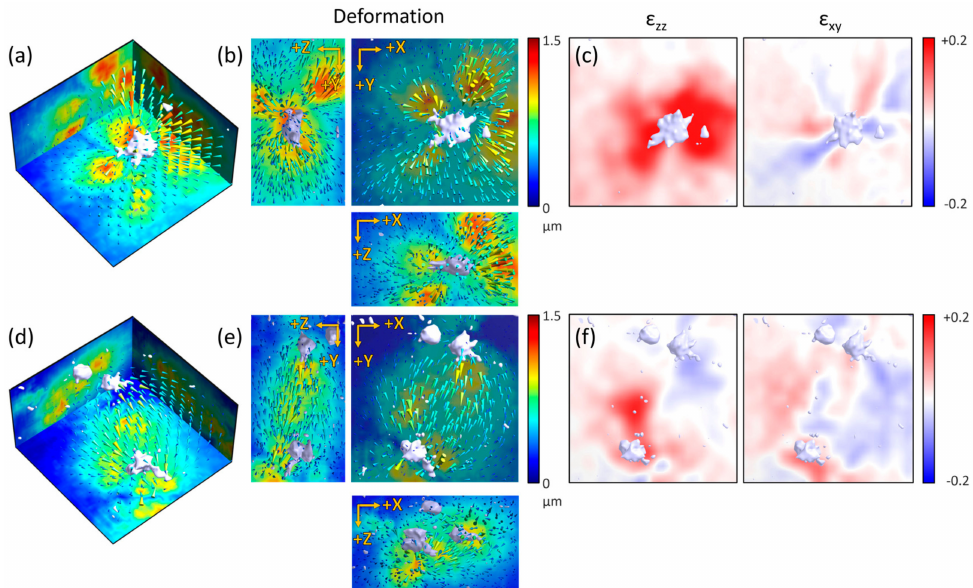
Figure 6. Visualization and analysis of the cell–ECM physical interactions of a single sprouting human umbilical vein endothelial cell (HUVEC) and two distant HUVECs. ( a ) Volumetric view of the color-coded displacement map of the collagen gel structure by one vein endothelial growth factor (VEGF)-treated sprouting HUVEC. ( b ) Maximum projections of the displacement map ( a ) in each axis. ( c ) Normal and shear strain tensor of ( a ) as sliced along the XY plane, 45 microns from the top surface (median of the axial field of view). ( d ) Volumetric view of the color-coded displacement map of the collagen gel structure by two distant VEGF-treated sprouting HUVECs. ( e ) Maximum projections of the displacement map ( d ) in each axis. ( f ) Normal and shear strain tensor of ( d ) sliced along the XY plane, 45 microns from the top surface (all fields of view are 160 × 160 × 90 µ m 3